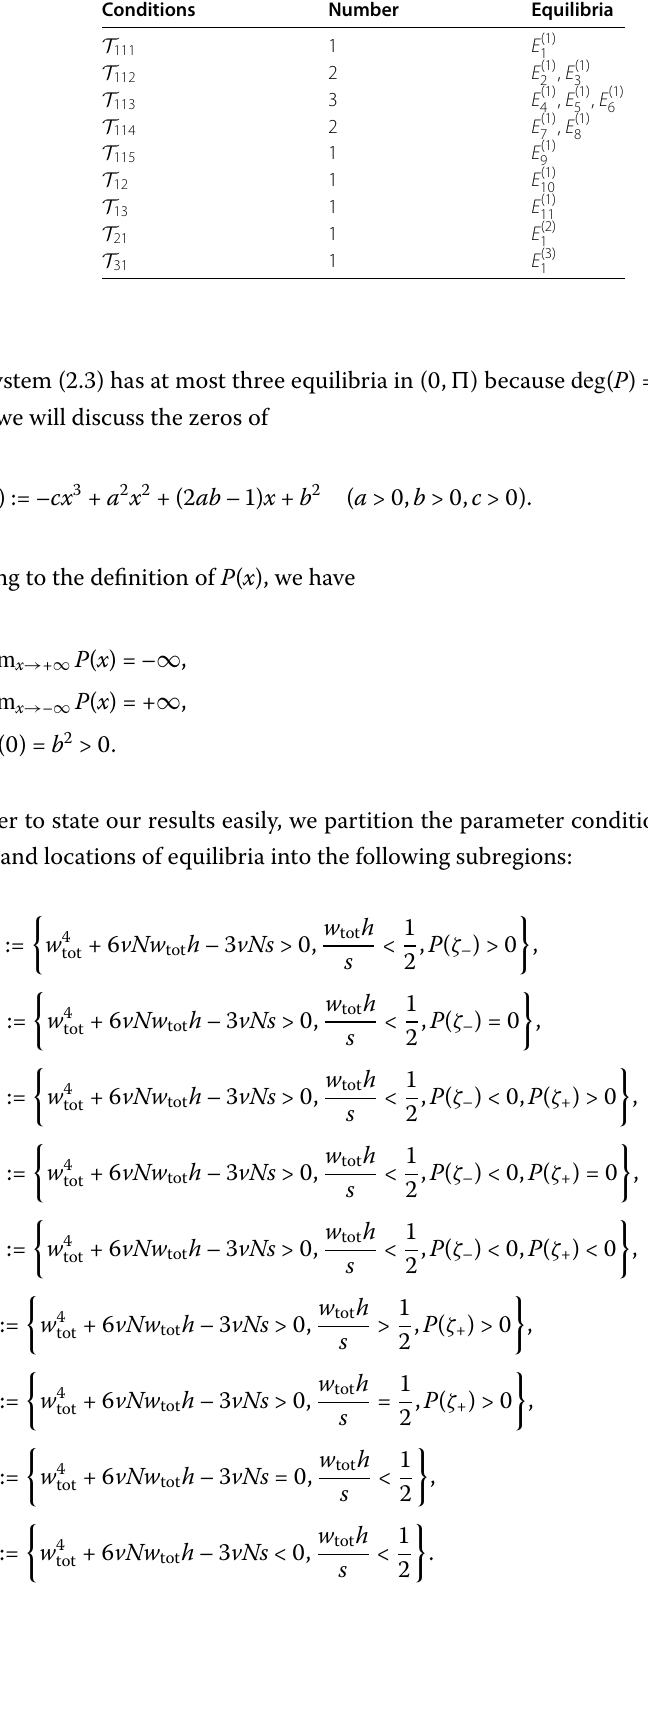
Table 1 The number of equilibria and their locations Conditions